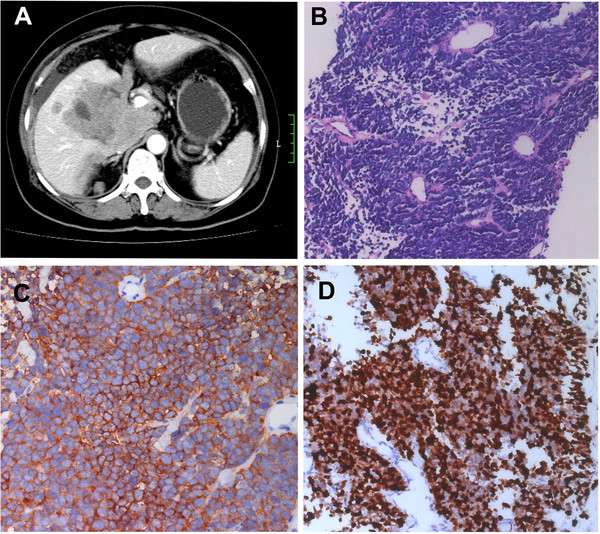
Radiological and pathological data of the case before chemotherapy. A. CT scan showed a gallbladder mass invading liver, head of pancreas with metastasis of peritoneum and enlarged lymphnodes in hepatic hilar. B. Diffuse small round cells with scanty cytoplasm and round nucleus (HE×200). C. Strong positive cytoplasmic expression of Syn (IHC×400). D. Over 80 % tumor cells show positive expression of Ki-67 (IHC×200).